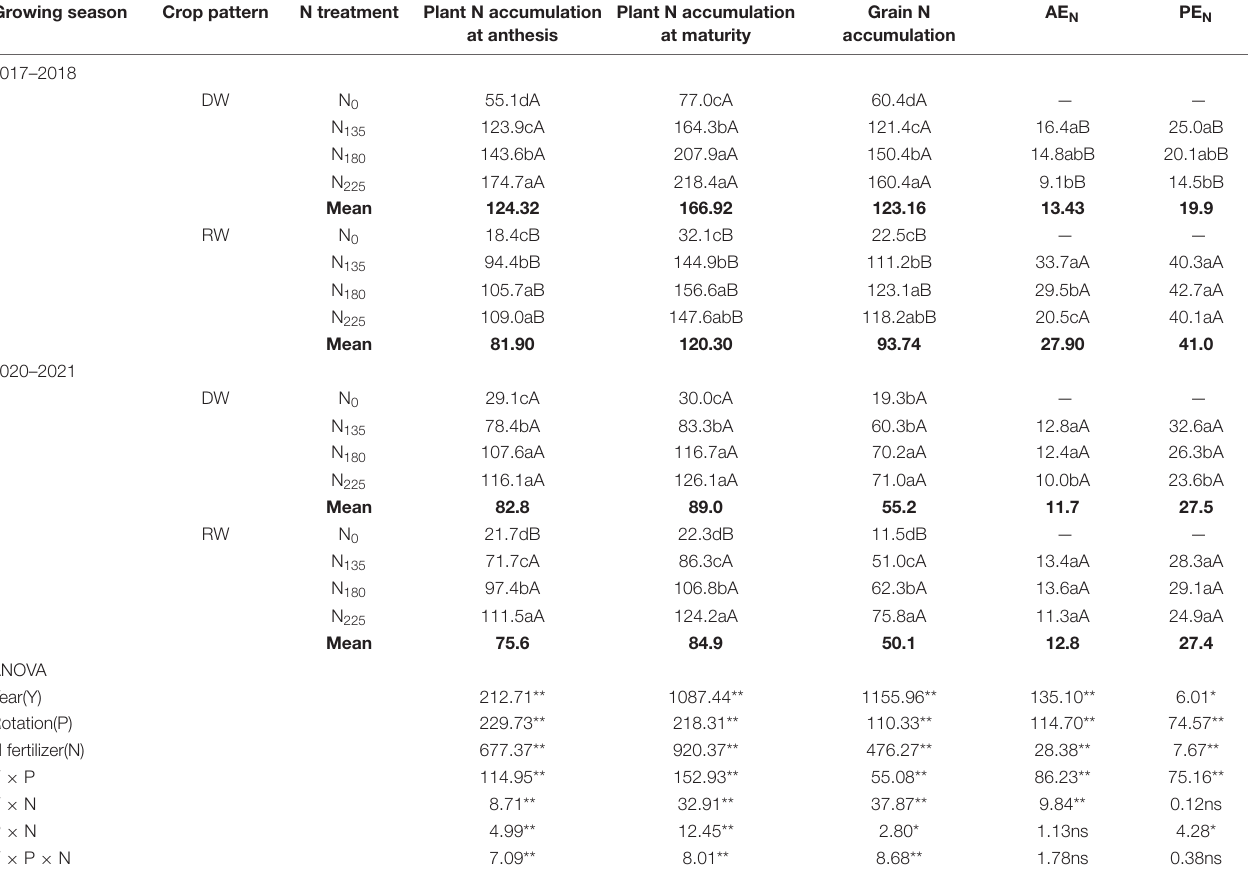
TABLE 2 | Responses of nitrogen accumulation and nitrogen use efficiency of wheat under dryland wheat (DW) and rice stubble wheat (RW) to increased nitrogen fertilizer application. Growing season Crop pattern N treatment Plant N accumulation at